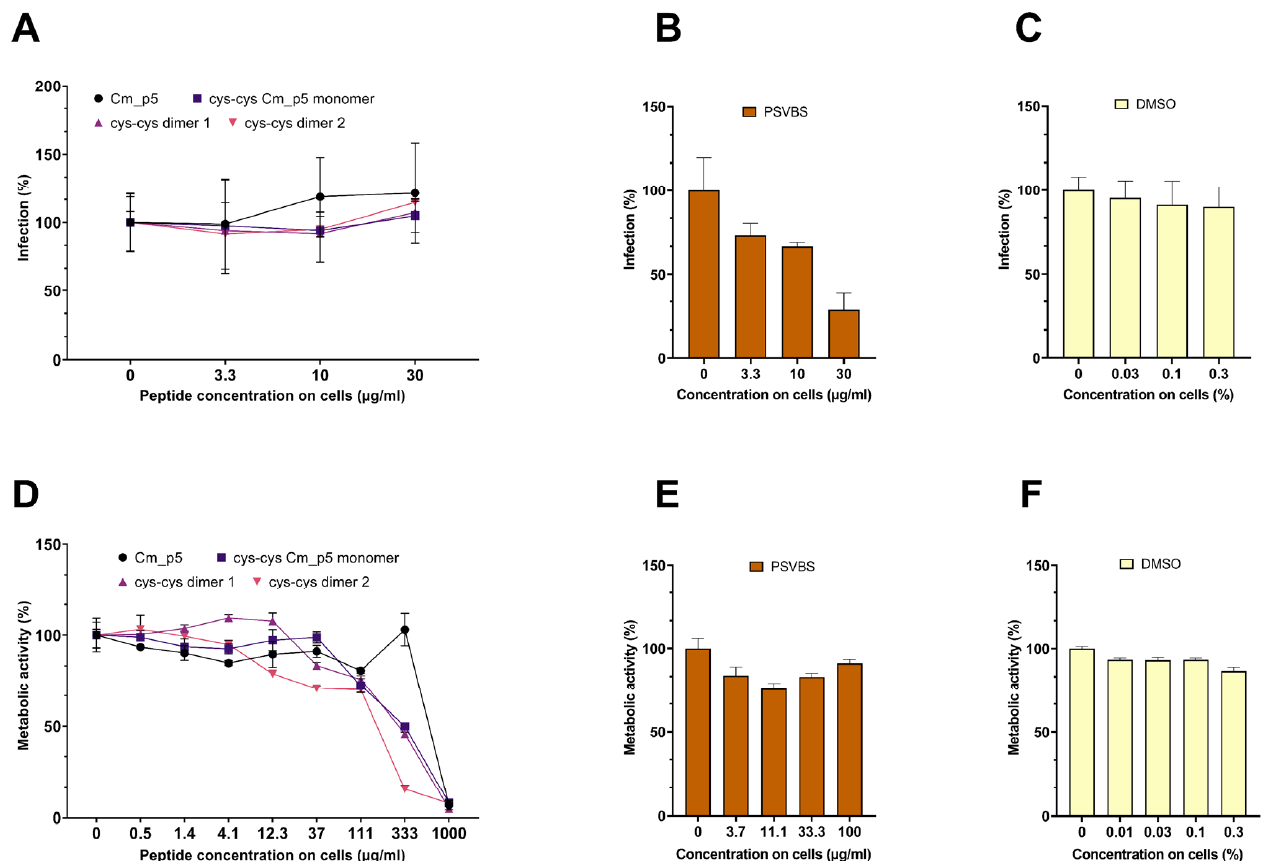
Figure 4. Effect of Cm-p5 and derivatives on ZIKV infection. ( A – C ) ZIKV was incubated for 1 h at 37 ◦ C with the peptides, DMSO control, or the polyanionic ZIKV inhibitor PSVBS. Thereafter, Vero cells were inoculated with the mixtures (resulting in the indicated concentration of the peptides on cells) and the viral infection rates were determined 2 days later, by quantifying the viral E protein by in-cell ELISA. Shown are mean values derived from triplicate infections ± SD (relative to controls containing no peptide, 100%). ( D – F ) Metabolic activity of Vero cells that were incubated for 2 days with the indicated concentrations of peptides and controls. Cell viability was determined by the MTT assay. The effect of the Cm-p5 compound was measured in an independent experiment, but are shown in the same figure. The values shown are the means derived from triplicate measurements ± SD (relative to the controls containing no peptide,